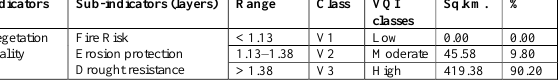
VQI VQI Classes Figure 6. The distribution of vegetation quality index OM